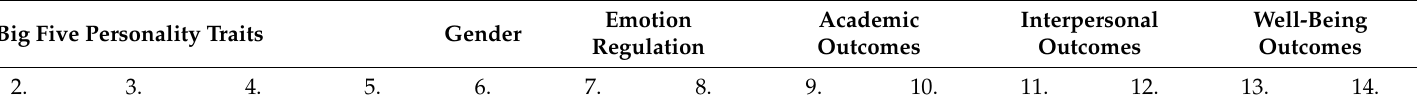
Table 1. Zero-order correlations among all study